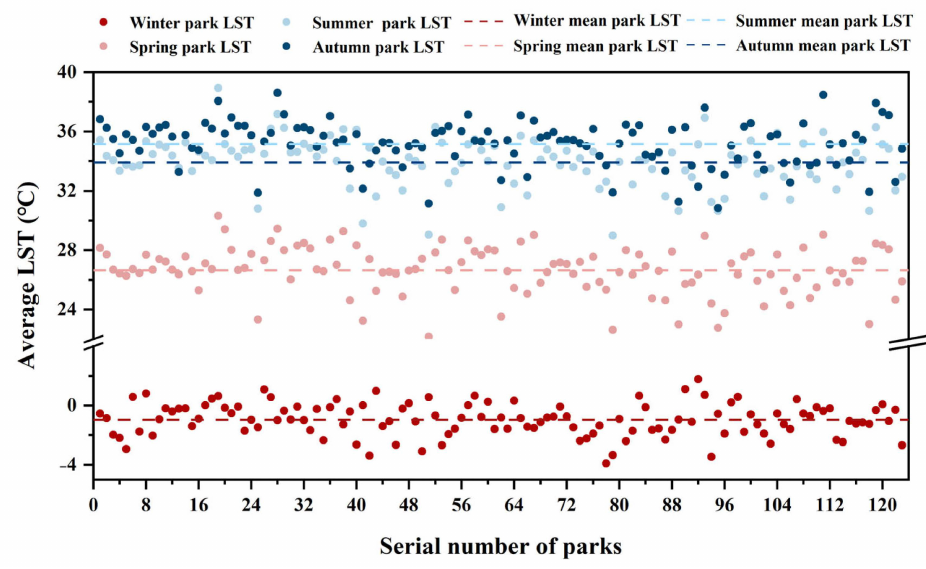
Figure 5. LST of parks in four seasons. Table 1. Park LST and LST differences in different